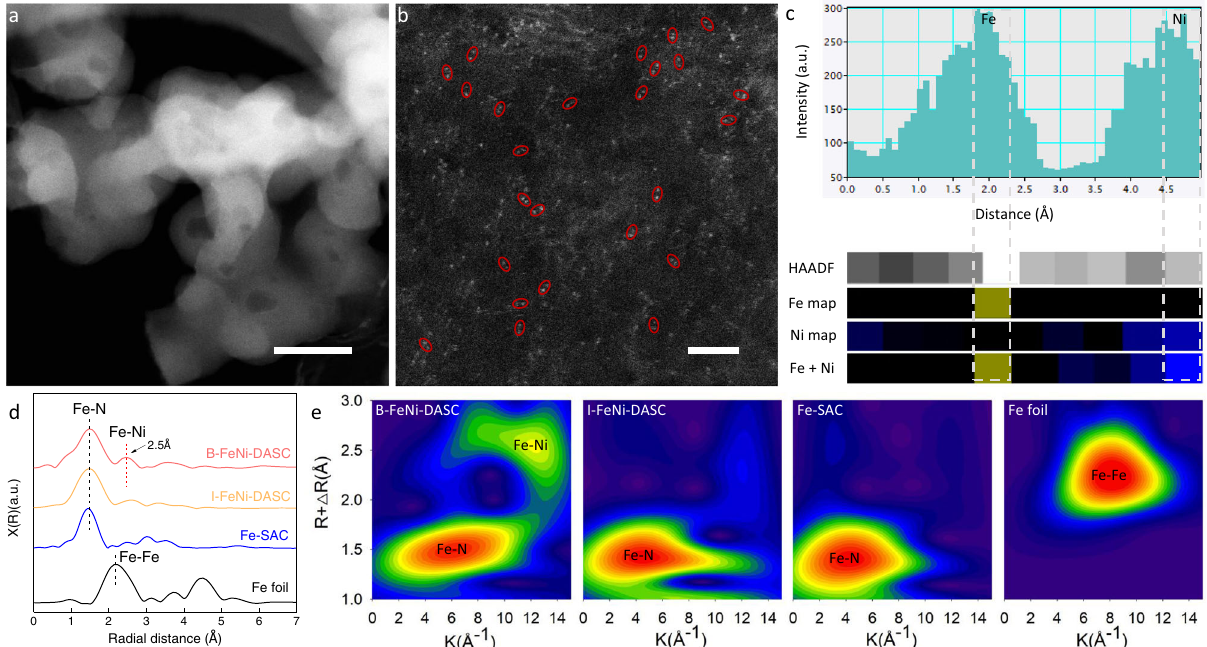
Fig.1|Morphologyandstructureofsingle-atomanddiatomiccatalysts.a TEM image and b Aberration-corrected HAADF-STEM image of B-FeNi-DASC. The scale bar is 100 and 2nm, respectively. c Acquired HAADF-STEM image intensity pro fi le accompanied by atomic-resolution EELS mapping of the Fe – Ni pair. d